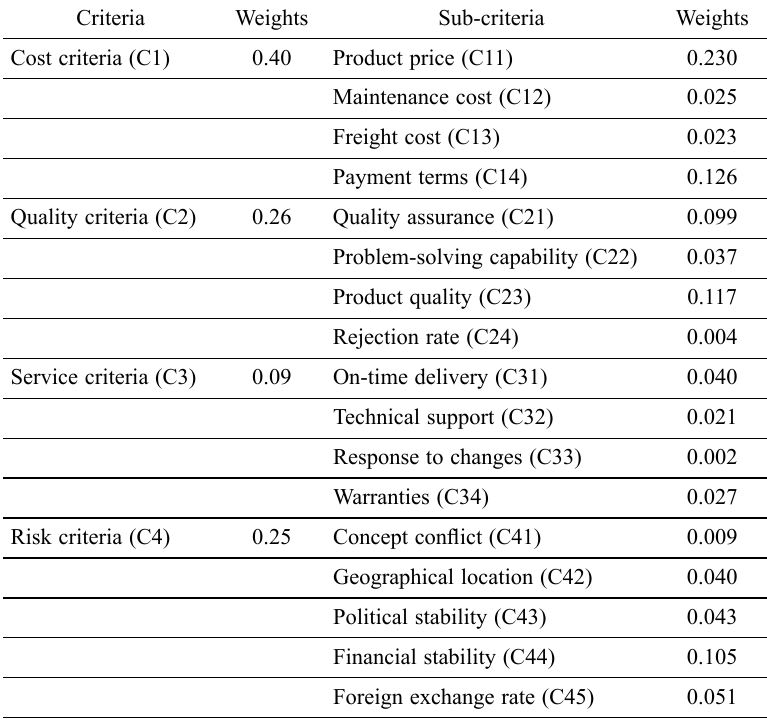
Table 12. Global weights of criteria and